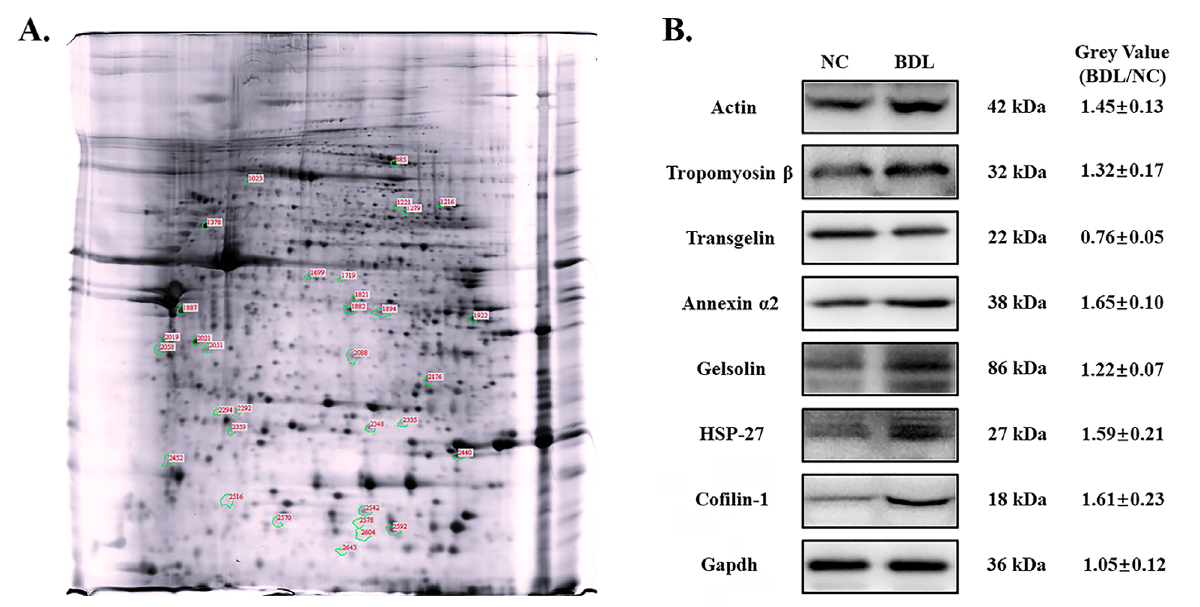
Figure 2 - Differentially expressed protein spots in artery of obstructive jaundice patients. A. Representative analytical proteome map of obstructive jaundice. B. Western blot analysis for seven actin or actin-related proteins identified by DIGE analysis. Table 2 - Identification results of proteins expressed in obstructive jaundice vs. non-jaundice patients. protein